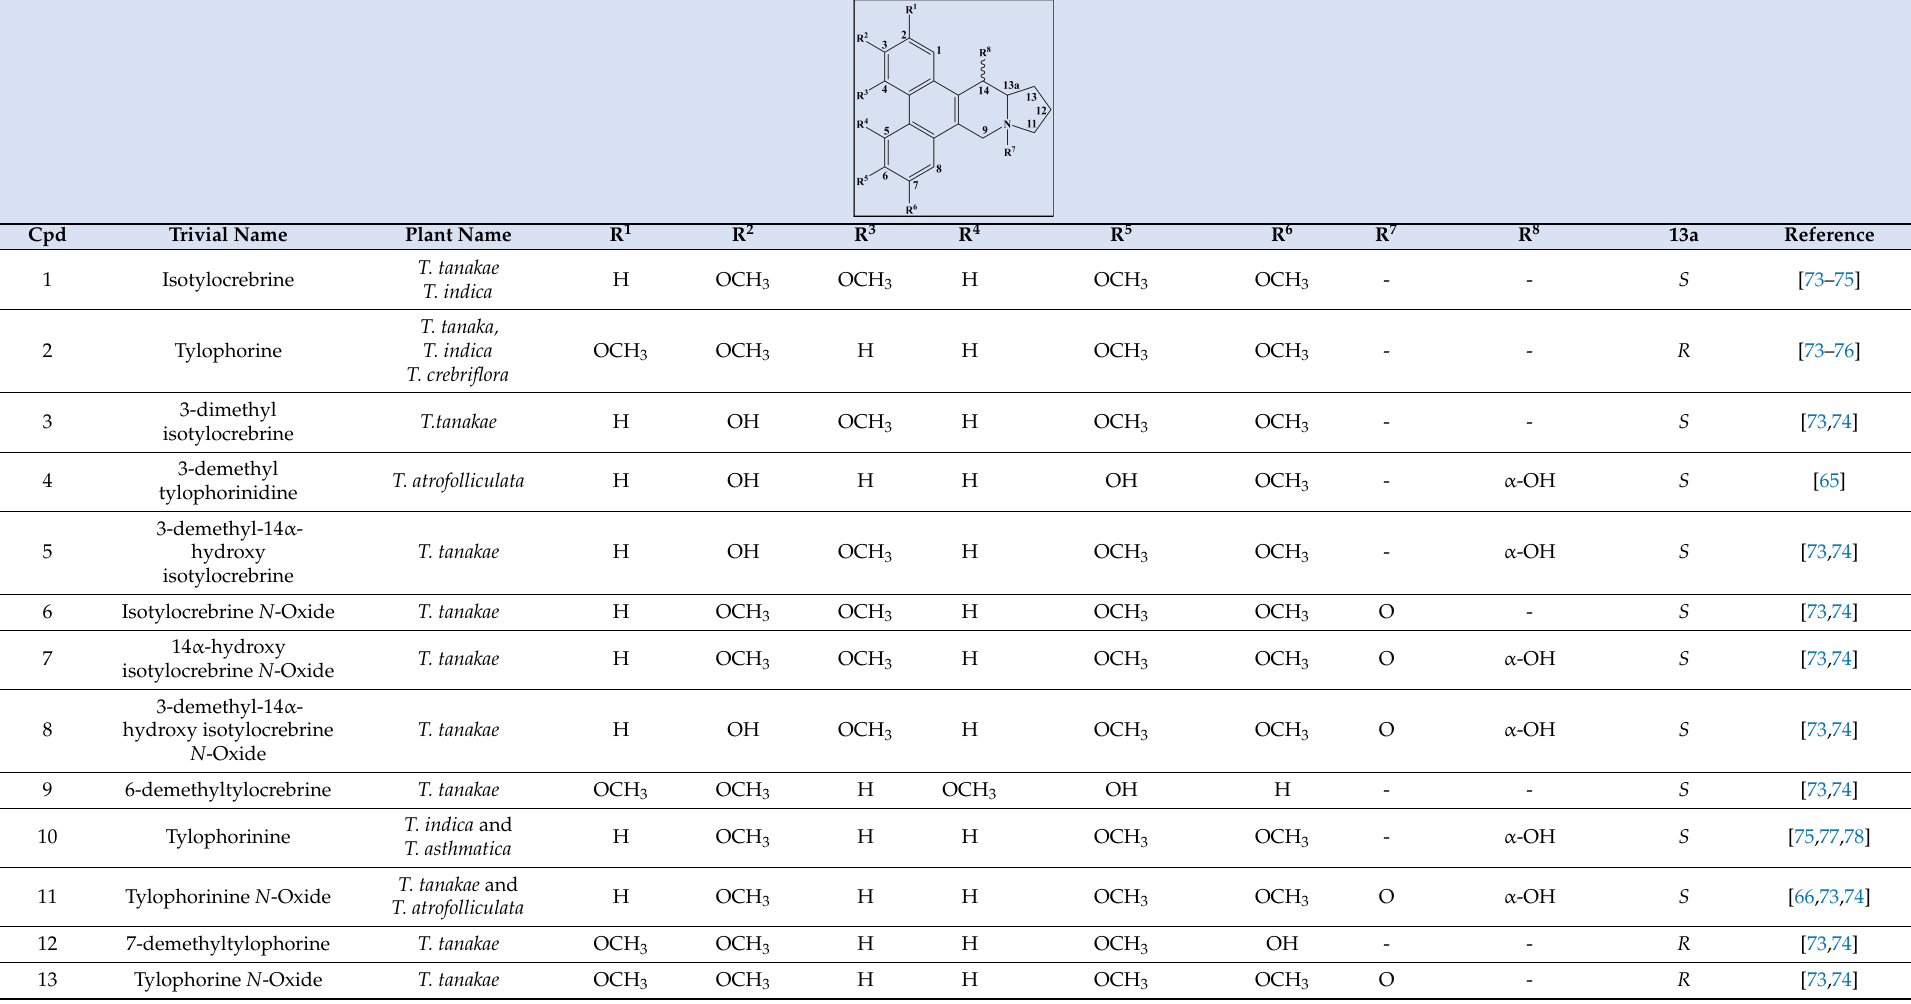
Table 3. Phenanthroindolizidine alkaloids isolated from the genus Tylophora